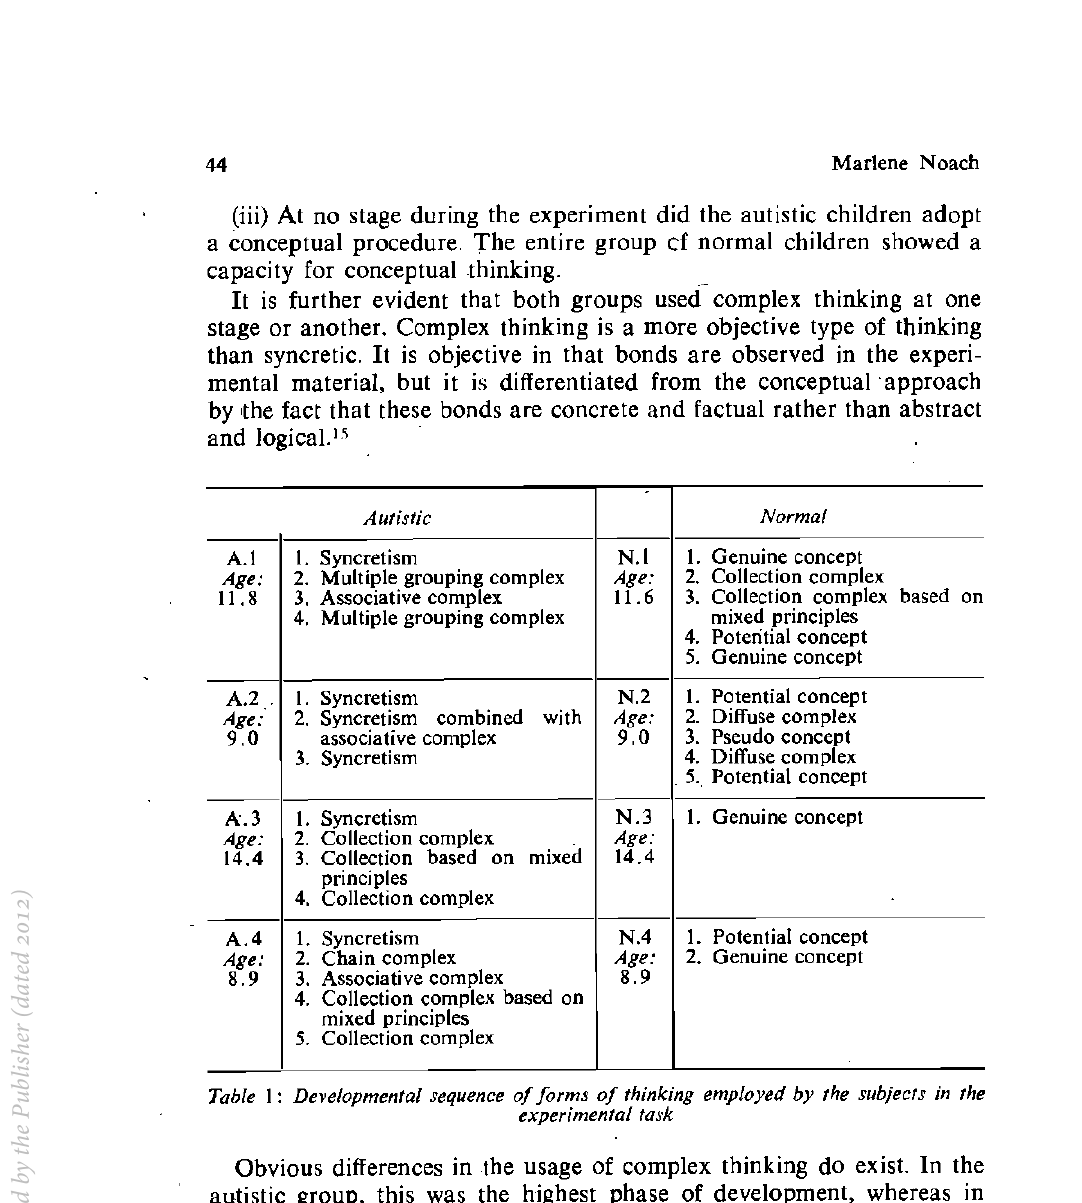
Table 1: Developmental sequence of forms of thinking employed by the subjects in the experimental task Obvious differences in the usage of complex thinking do exist. In the autistic group, this was the highest phase of development, whereas in the normal group complex thinking preceded the conceptual